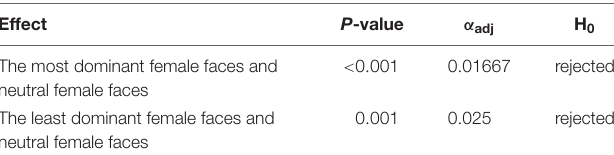
TABLE 7 | The results from the sequential Bonferroni correction of three different t -tests for female faces of Experiment